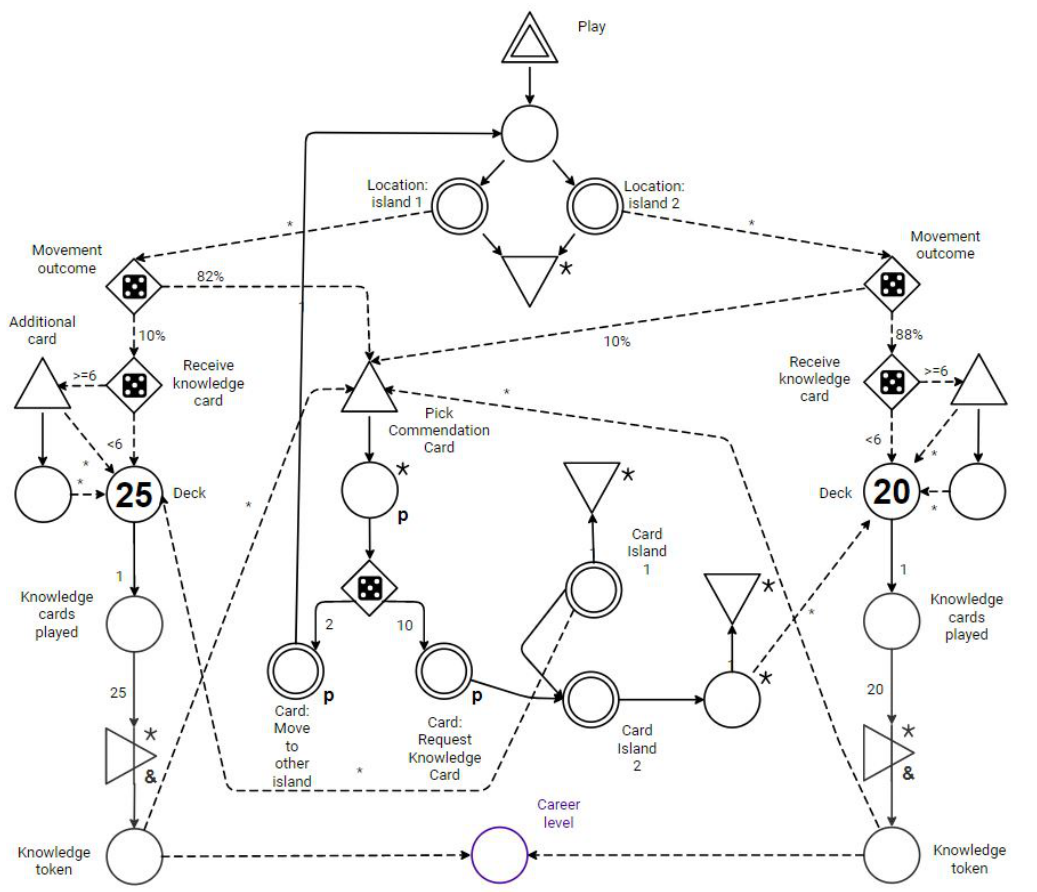
Figure 6. MARISA Game machinations diagram